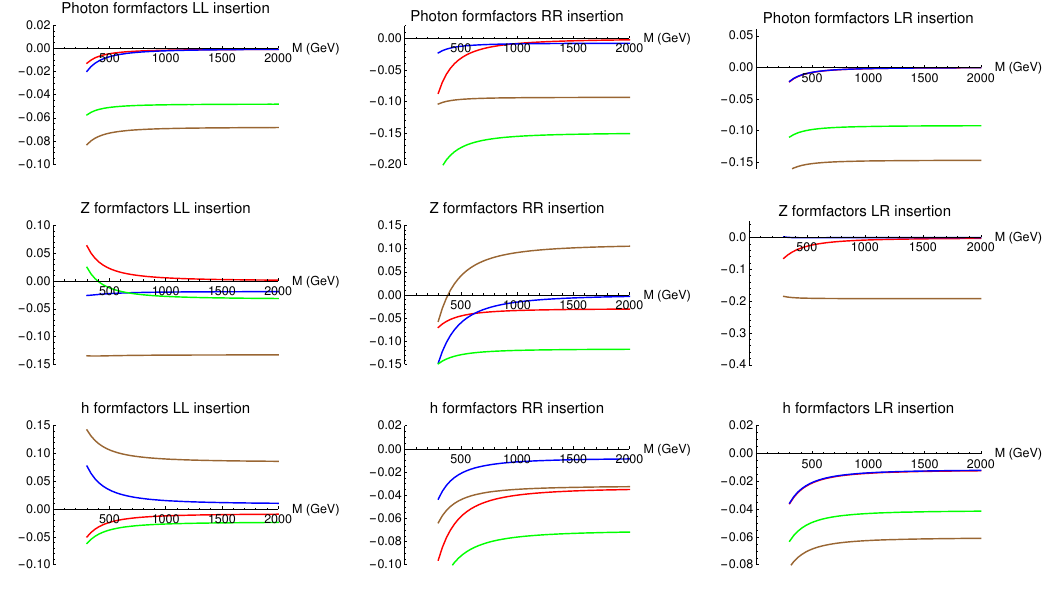
Figure 6 . Accuracy of MI expansion for the penguin amplitudes. The curves show the ratio de(cid:12)ned in eq. (4.4). Red and blue lines: (cid:1) F for left and right couplings assuming a spectrum of eq. (4.3) for both the MI and ME expressions. Brown and green lines: (cid:1) F (again for left and right couplings, respectively) assuming spectrum (4.3) for ME expressions but an universal degenerate sfermion mass in MI expressions. This assumption is inconsistent with non-zero o(cid:11)-diagonal elements of the mass matrices, which imply non-degenerate mass eigenstates. The plots show that the associated error can be numerically sizeable. The average SUSY mass scale M (assumed to be equal to M 2 = m ~ (cid:22) = m ~ (cid:22) ) is shown on the horizontal L R